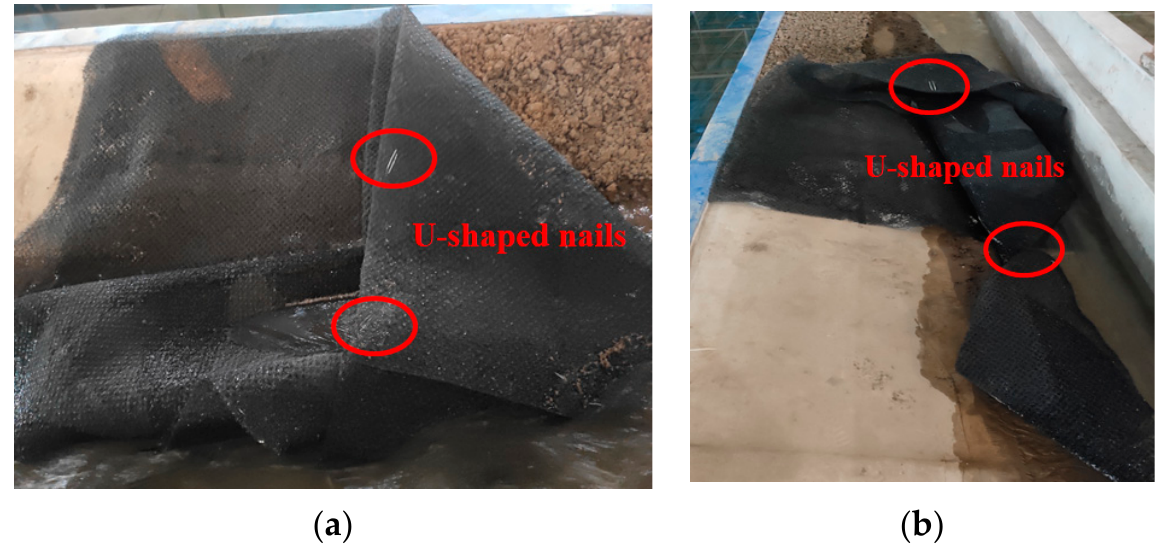
Figure 9. Damage types of Enkamat: ( a ) ejection of fixed nails and material lifting (RUN 12, after 3.5 h scouring); ( b ) material tearing after 4 h scouring.